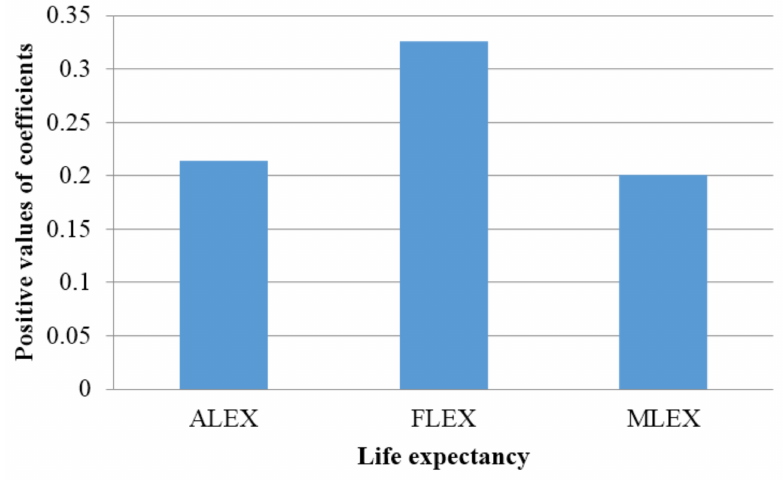
Figure 2. Comparison of magnitudes of impact of PM 2.5H on the three variables of life expectancy. Note: ALEX indicates aggregate life expectancy; FLEX is female life expectancy; MLEX refers to male life expectancy.